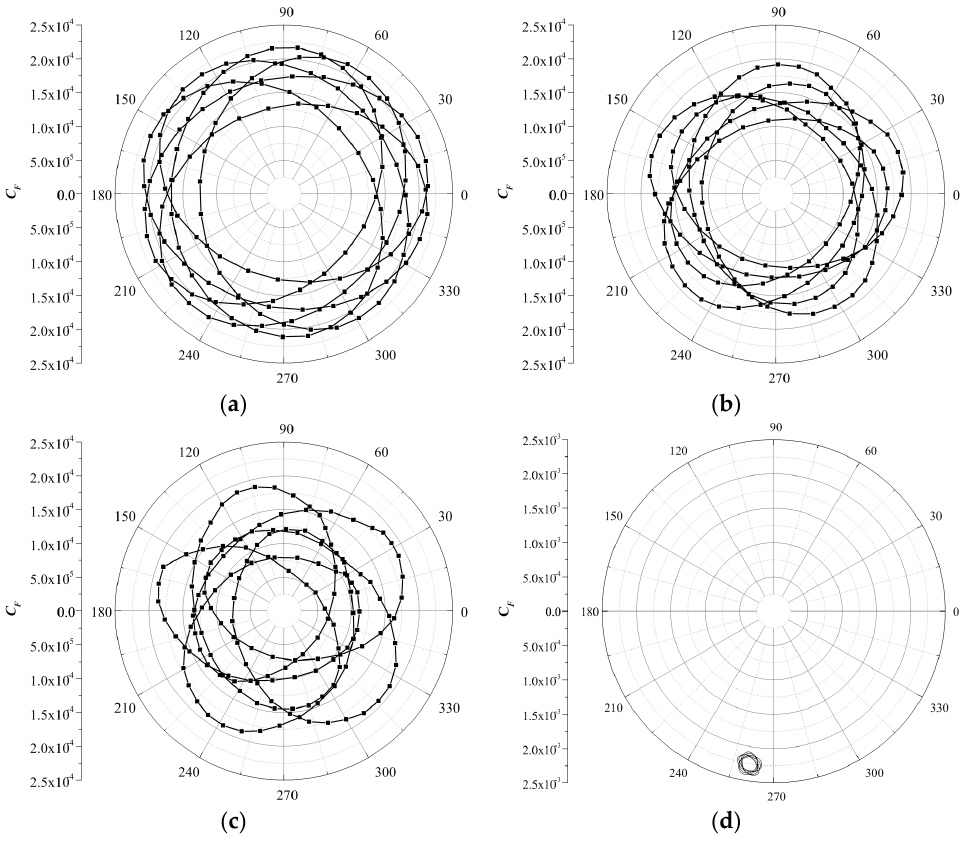
Figure 7. Radial force vector on principal axis for different tip clearances: ( a ) 0 mm; ( b ) 1 mm; ( c ) 2 mm and ( d ) 1 mm + 2 mm.